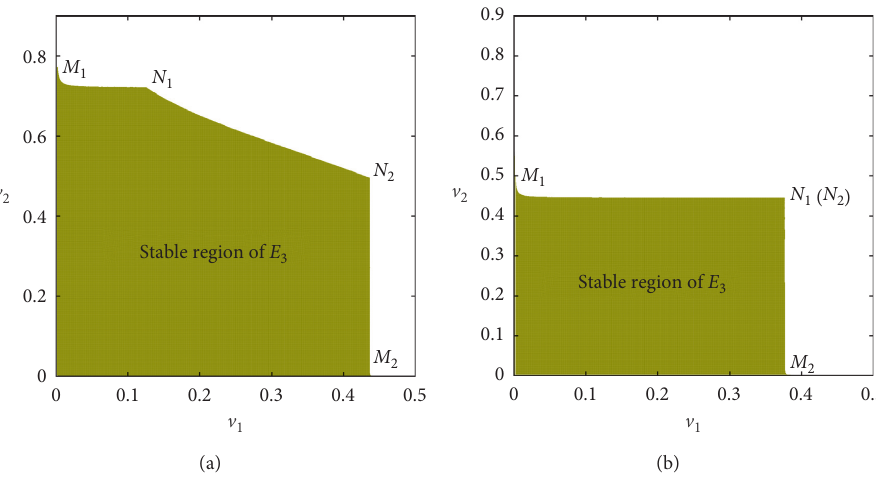
Figure 1: The stable region in the parameter space ( v α � 0 . 9 , β � 0 . 75 , and a − c